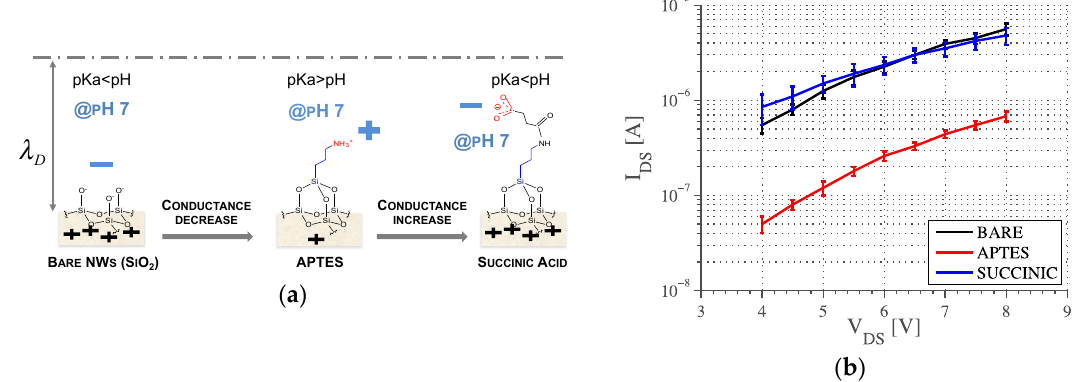
Figure 10. ( a ) Change in the surface charge at pH = 7 for different surface chemistry. The surface is deprotonated for both bare and succinic treated NWs while it is slightly protonated for APTES treated NWs; ( b ) DC measurements on NWs with different surface chemistry, pH = 7.